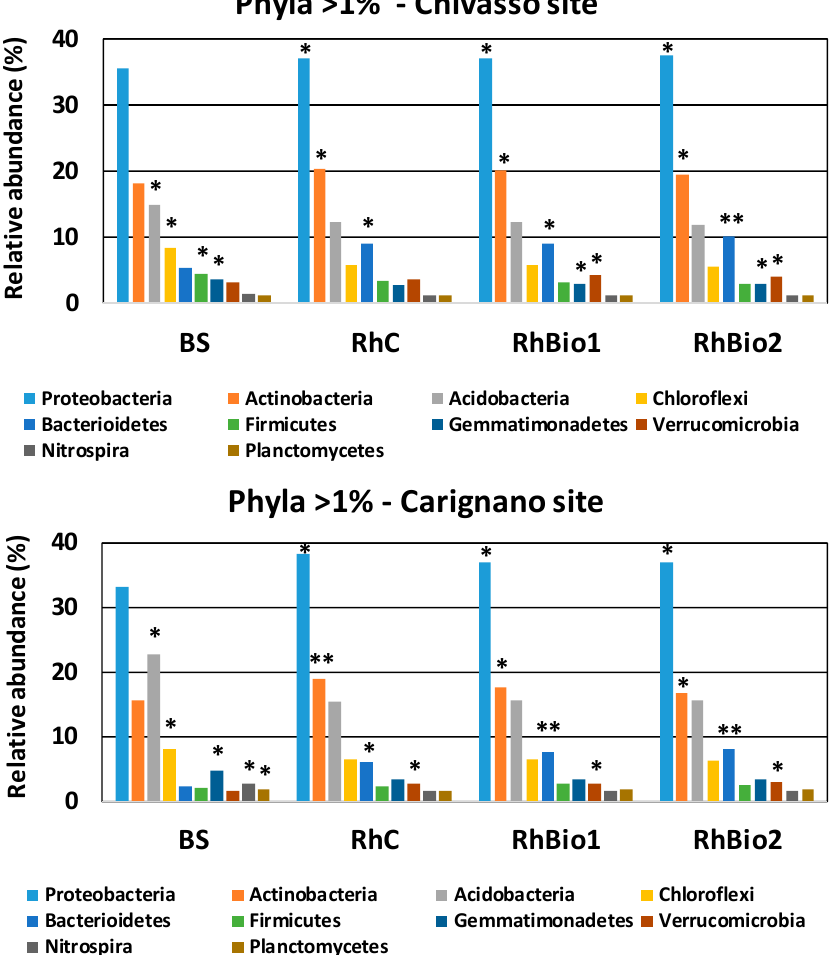
Figure 4. The percentage of phyla present at >1% in all the soil samples from the two sites, Chivasso and Carignano, based on 16S rDNA reads. BS = bulk soil; RhC = rhizosphere of control plants; RhBio1 = rhizosphere of plants from seeds coated with Bio1; RhBio2 = rhizosphere of plants from seeds coated with Bio2. Data from each soil type are derived from four biological replicates (each consisting of the rhizosphere of six plants). Significantly different values among treatments within same site are indicated with asterisks, (* p ≤ 0.05; ** p ≤ 0.01).